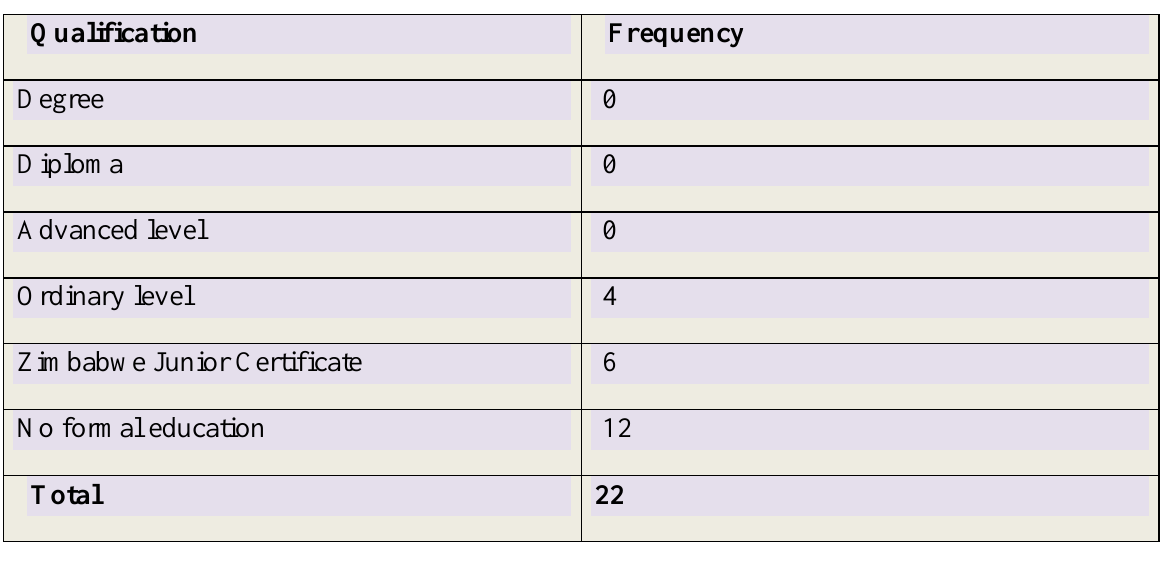
Table 5.7: The parents’ level of